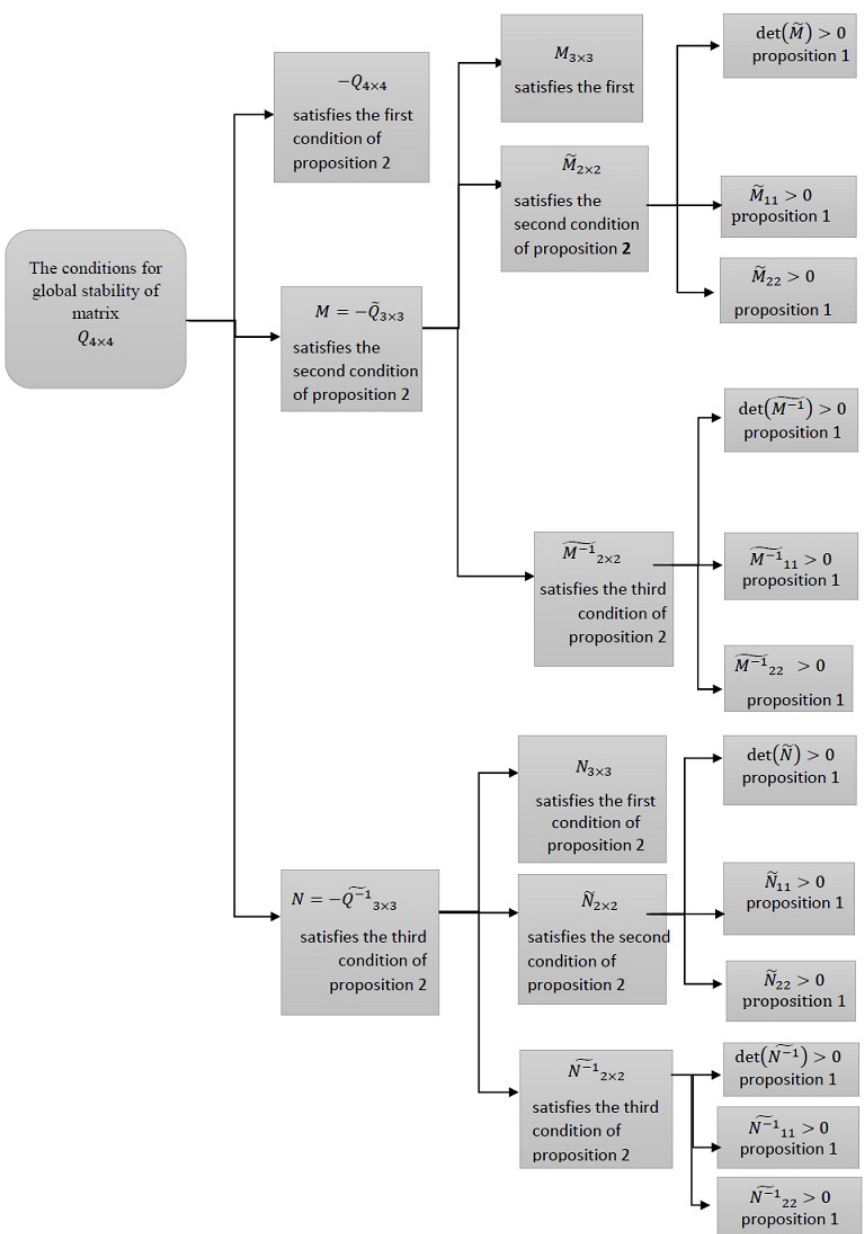
Figure 1. Describing the presented method using Propositions 1 and